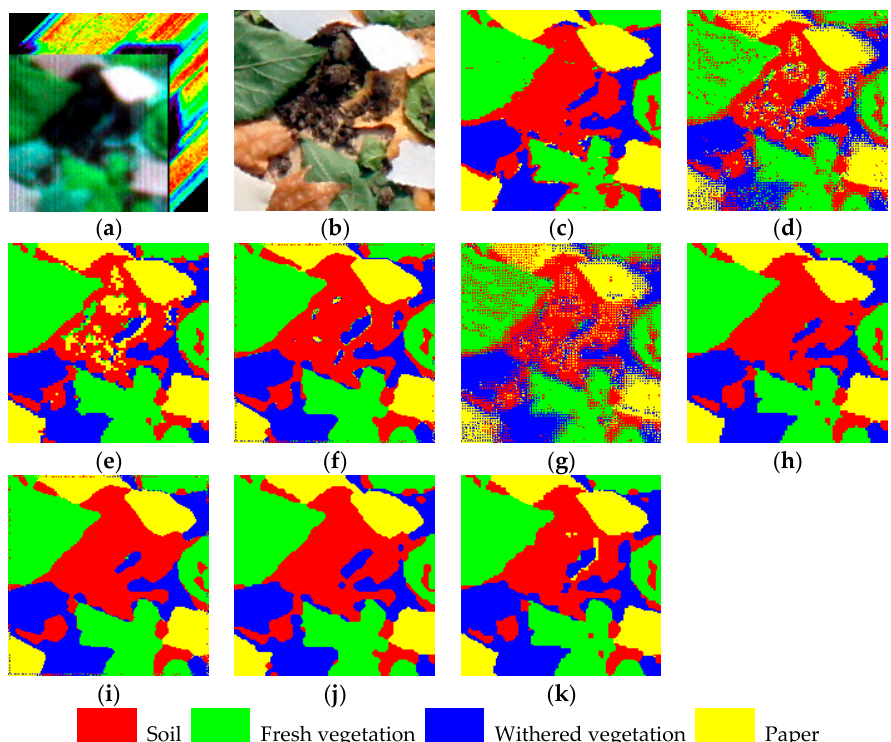
Figure 6. Sub-pixel mapping results for the Nuance dataset: ( a ) original low-resolution hyperspectral imagery; ( b ) high-resolution image obtained with digital camera; ( c ) reference classification map obtained by SVM classifier for the high-resolution imagery; ( d ) sub-pixel mapping result obtained using FCLS+AM; ( e ) FCLS+HC; ( f ) FCLS+HNN; ( g ) SUnSAL-TV+AM; ( h ) SUnSAL-TV+HC; ( i ) SUnSAL-TV+HNN; ( j ) MRF; ( k ) JSSM. Table 4. Sub-pixel mapping results for the Nuance